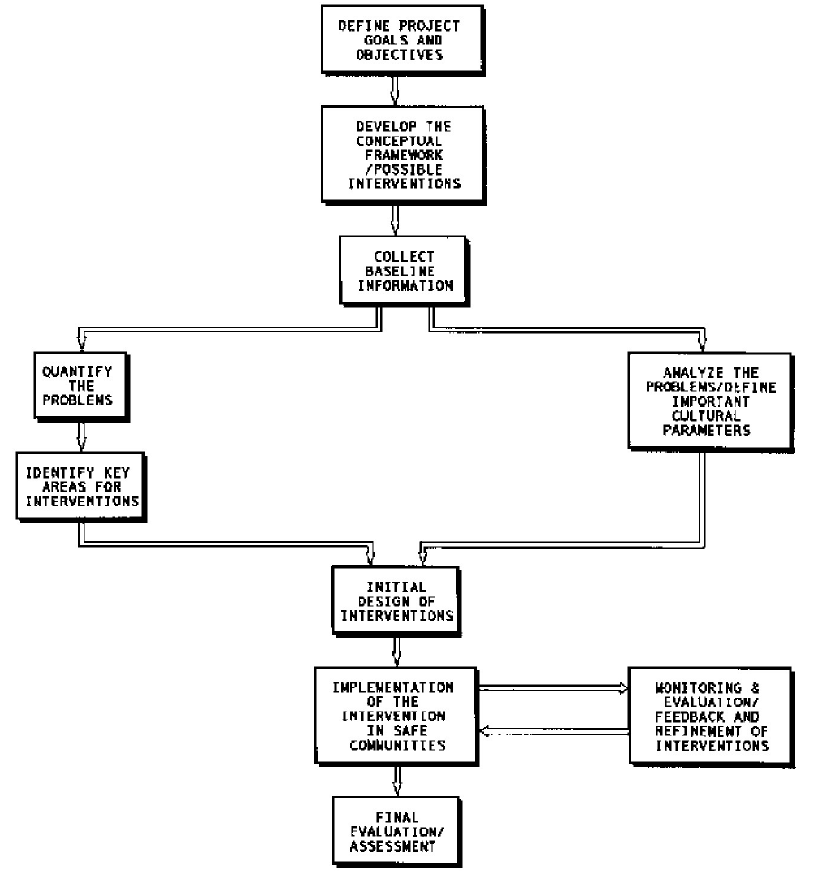
Fig 5. The SAFE project life